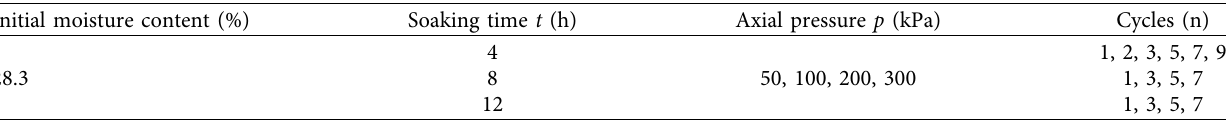
Figure 1: Compaction curve of red clay. Table 3: Direct shear experimental scheme under dry and wet cycles.